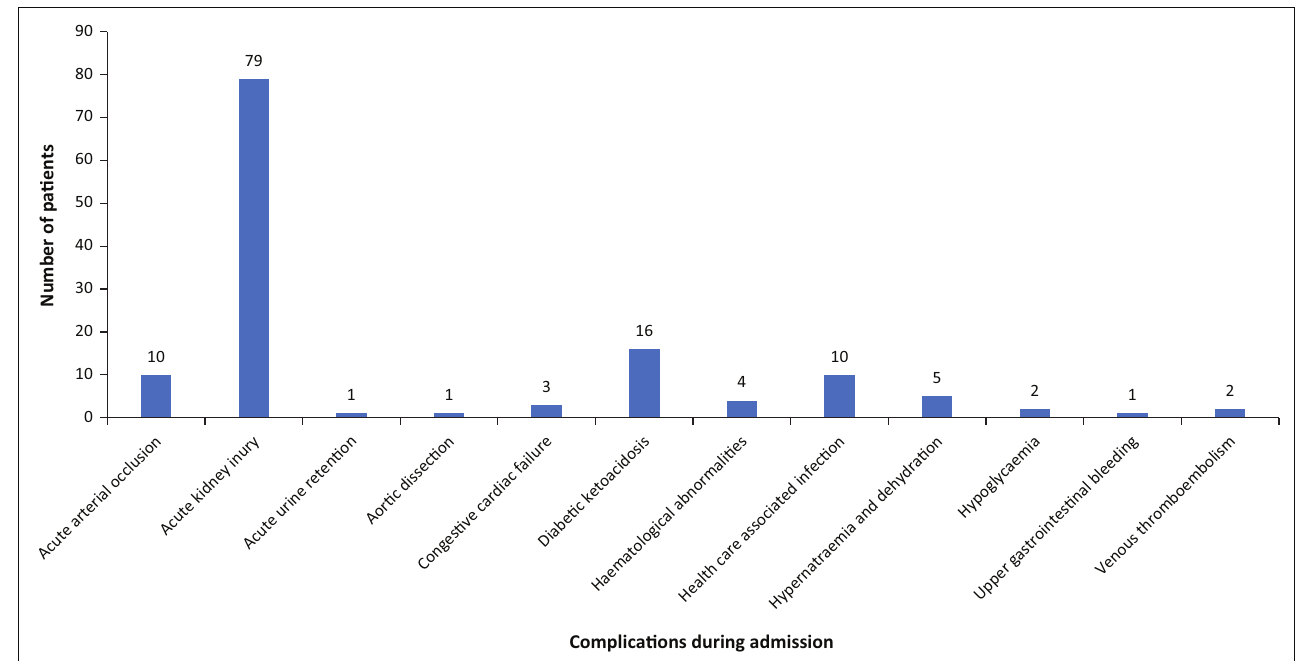
FIGURE 4: Acute complications amongst patients who died of TABLE 3: Risk factors for death. Risk factors for death